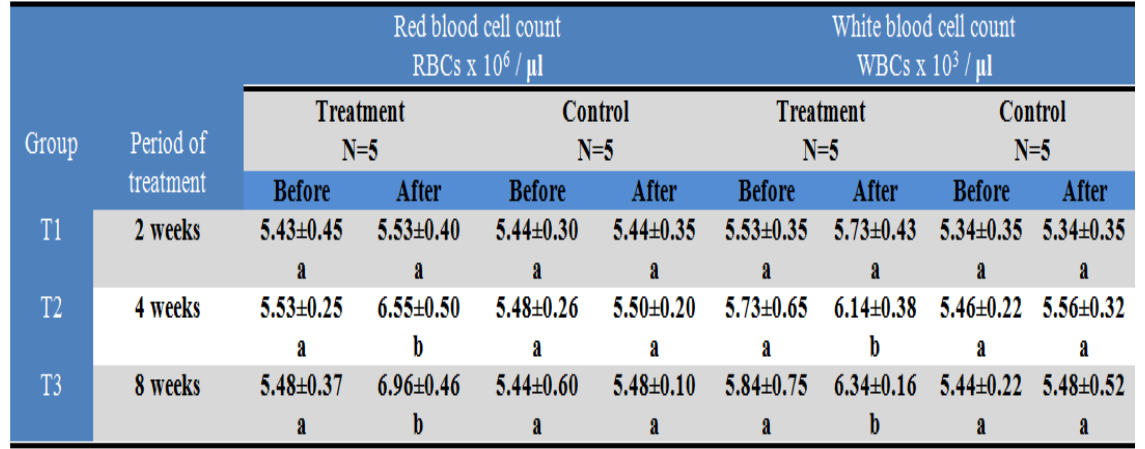
Table 5: Effect of orally administering a double dose (9.6mg/kg/day) of Citrullus colocynthis on the red and white blood cells count of rabbits in different periods.